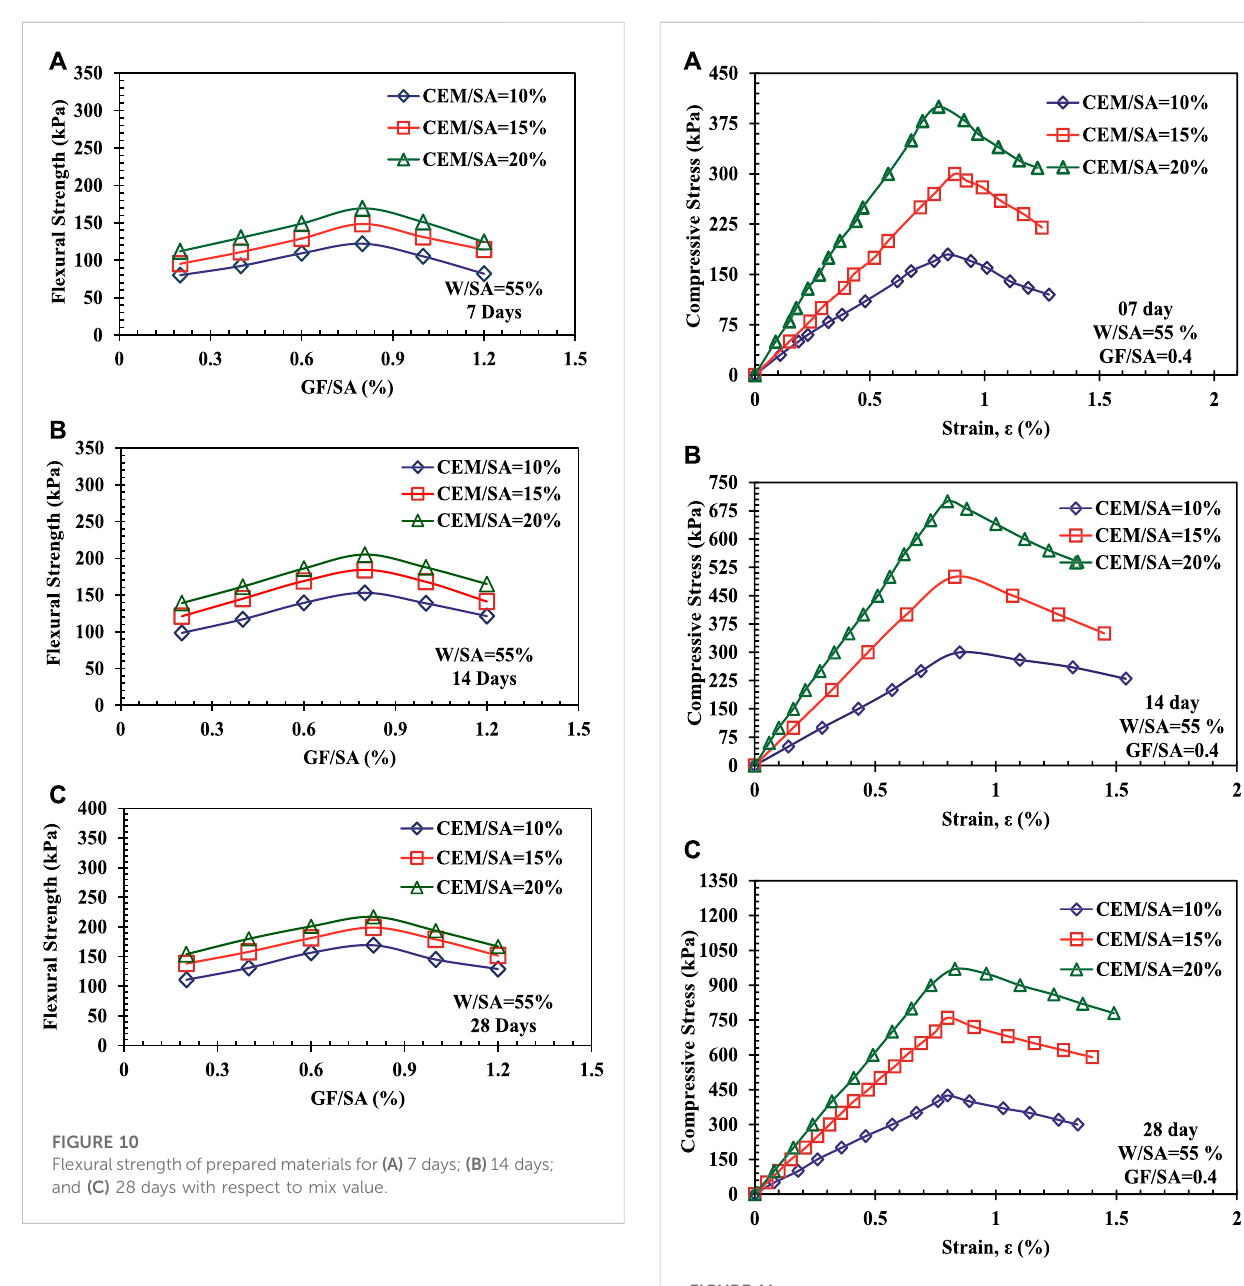
FIGURE 11 Stress – strain curve of SA and BF slag reinforced with glass fi ber undercompressive stressfor mixratiosof0.4%for (A) 7, (B) 14,and (C) 28